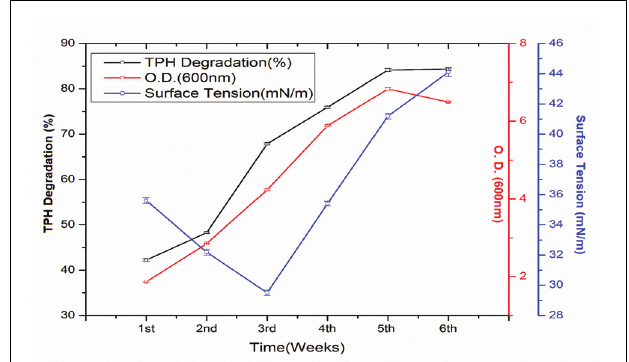
FIGURE 4 | Quantity of total petroleum hydrocarbon (TPH) degraded (%) by selected consortium at weekly intervals up to 6th week of incubation along with the optical density (growth of the consortium in the media) and ST of the culture medium. Bars represent the ± standard deviation ( ±